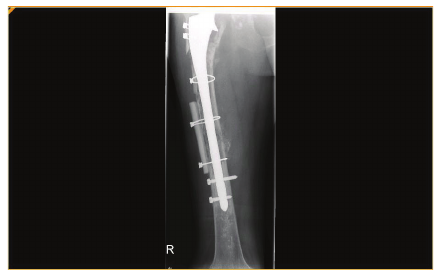
Figure 3: Postoperative fixation of periprosthetic fracture.